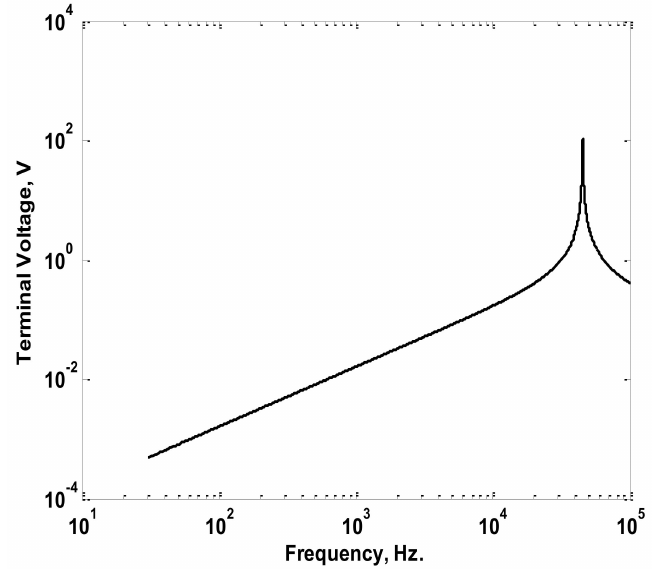
Figure 5. Maximum Terminal Voltages versus Frequency Characteristics of the Simulated Coil.